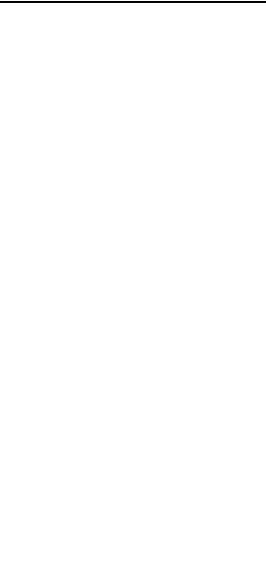
Table 2. Experimental design and application amount of